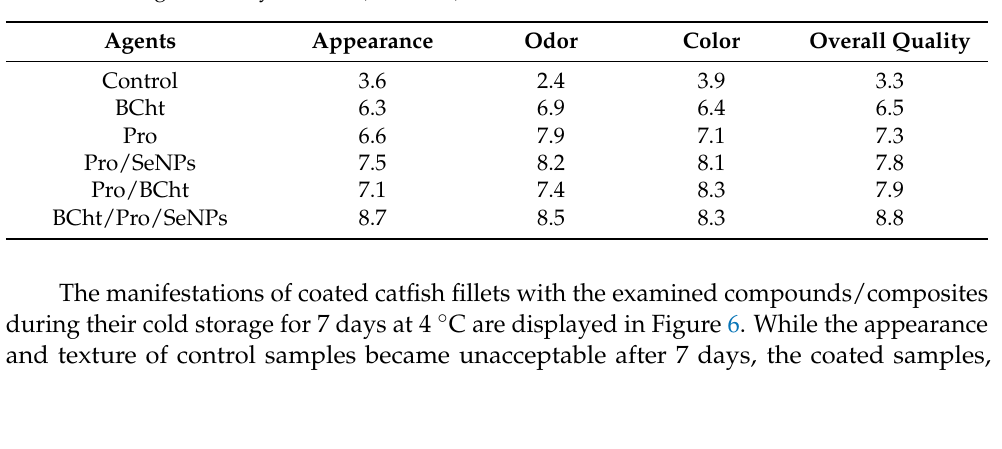
Table 4. Sensory evaluation of preserved fish fillets with coated fillets with antimicrobial compounds, after cold storage for 7 days at 4 ◦ C